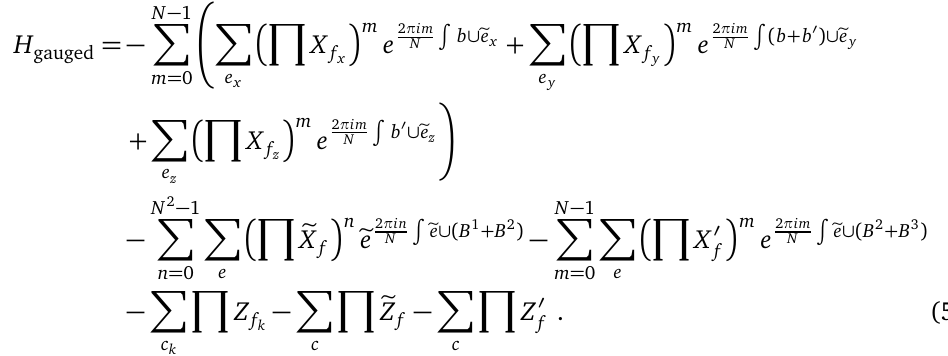
The faces on x i − x j plane has (cid:90) of freedom associated with b (cid:48) . The terms in the Hamiltonian model are shown in Figure 7. The ground state degeneracy on a torus of lengths L measured in the unit of lattice spacing can be computed using the method of [ 60, 61 ] and it equals N 2 L x + 2 L y + 2 L z